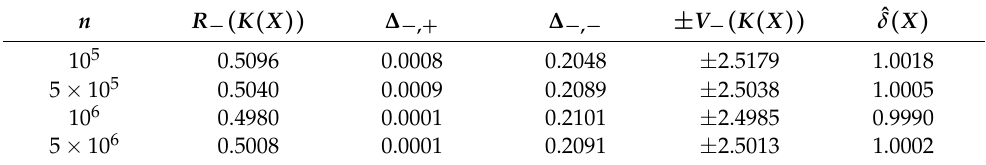
Table 1. Examples of estimates for the parameters of the model distribution GE ( 0.5;2.5;2.4;1.9;1.0 ) .